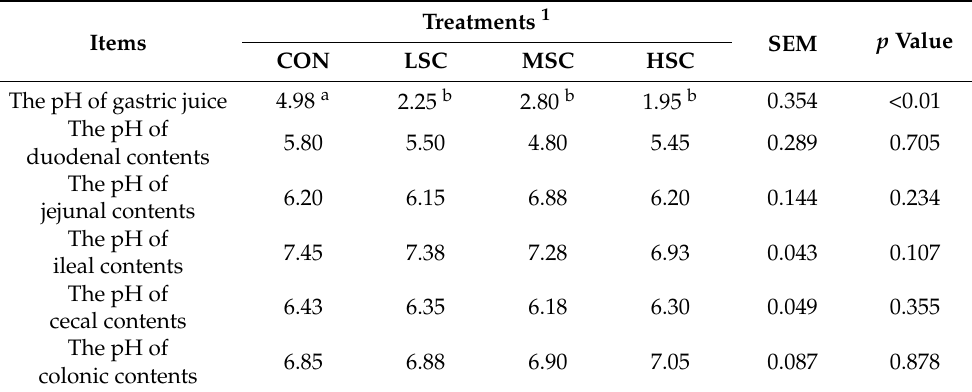
Table 4. Effects of yeast iron on the pH value of intestinal contents of weaned